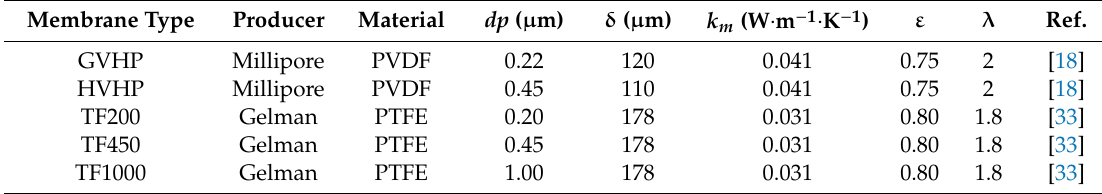
Figure 2. Schematics of the 2-D geometry model of the membrane module. Table 1. Properties of the selected membranes.